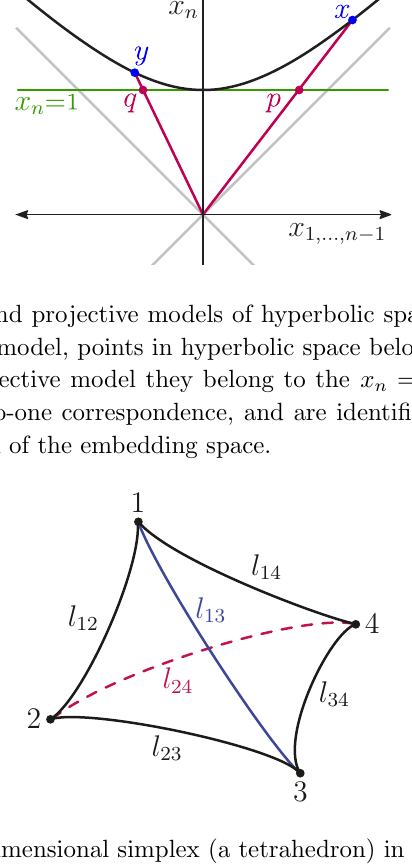
Figure 3 . A three-dimensional simplex (a tetrahedron) in hyperbolic space H 3